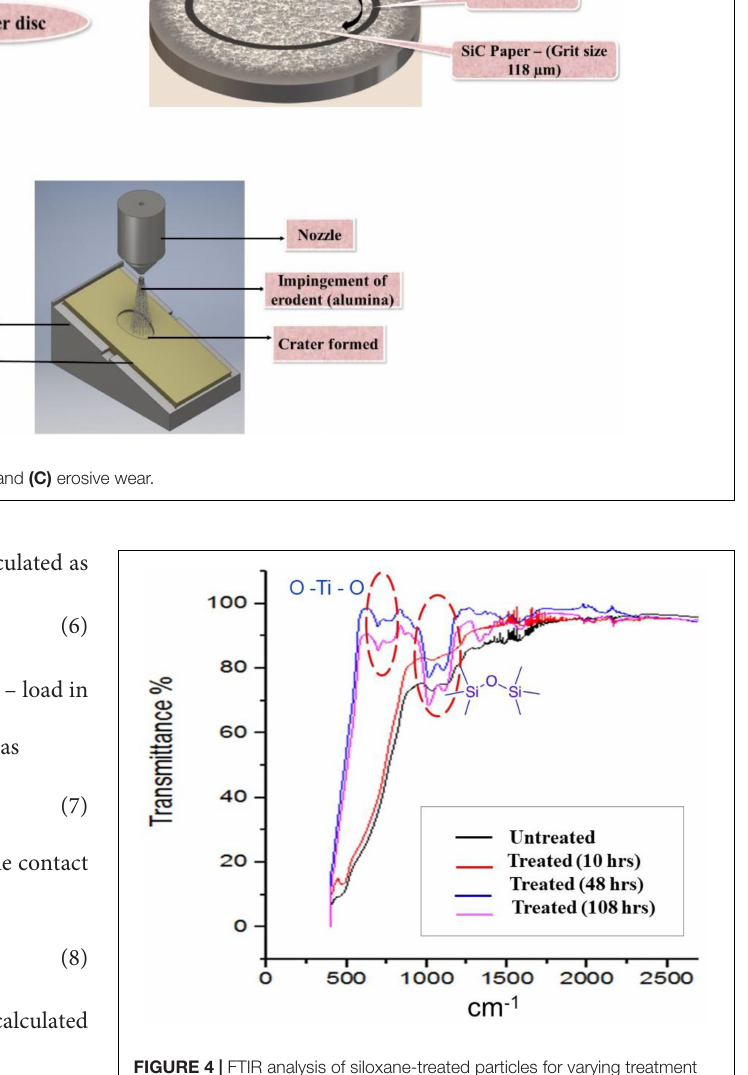
FIGURE 4 | FTIR analysis of siloxane-treated particles for varying treatment